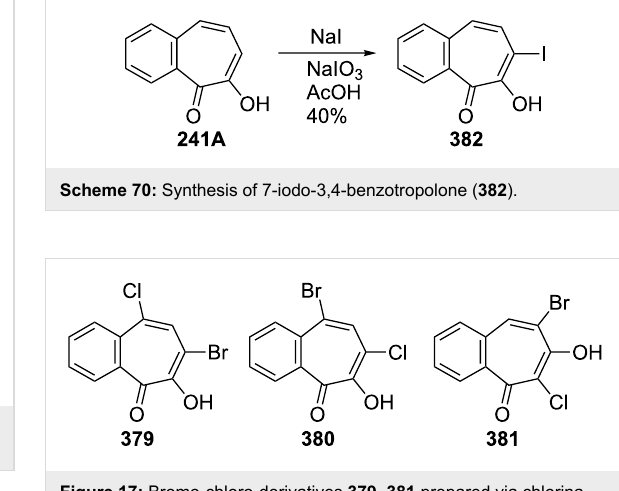
Figure 17: Bromo-chloro-derivatives 379 – 381 prepared via chlorina- tion.